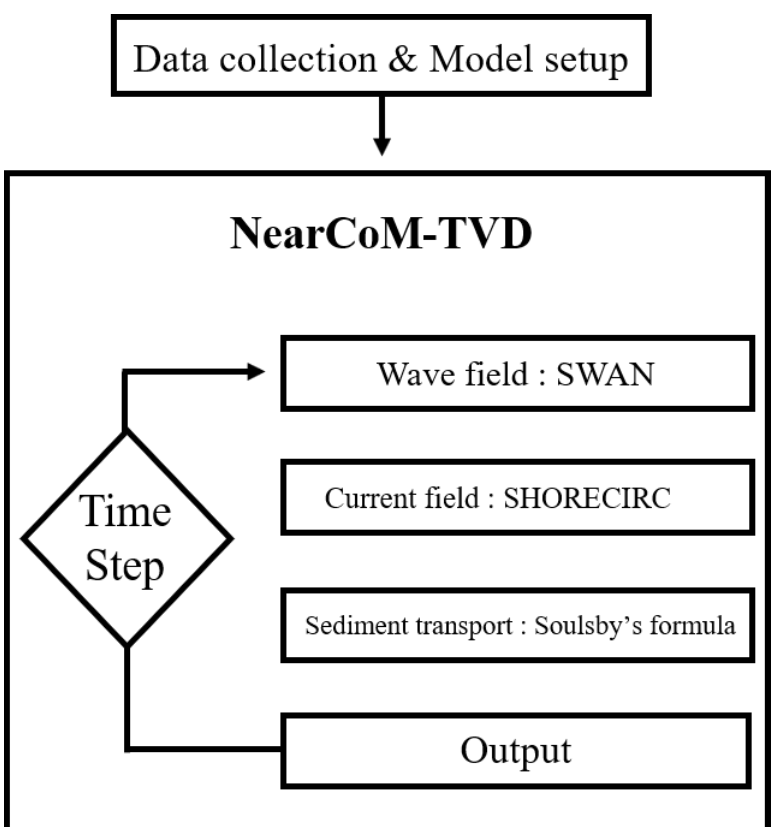
Figure 3. Flow chart of the coupling system.